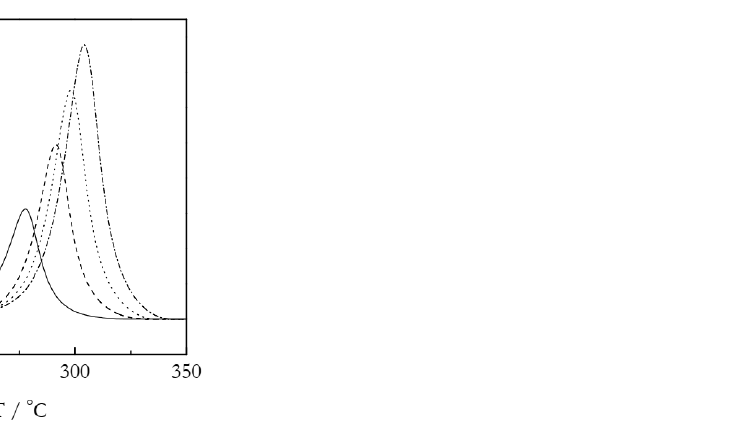
Figure 7. Experimental DSC curves for the polymerization of cyanate ester. Numbers by the lines are heating rates in K min − 1 . Adapted with permission from Galukhin et al. [54]. Copyright 2021 Wiley-VCH.